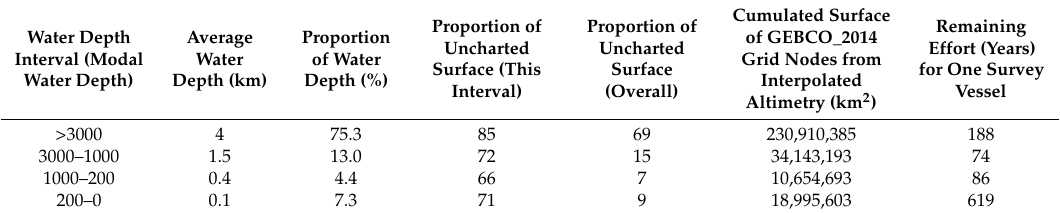
Table 3. Calculated survey effort needed to completely map the world